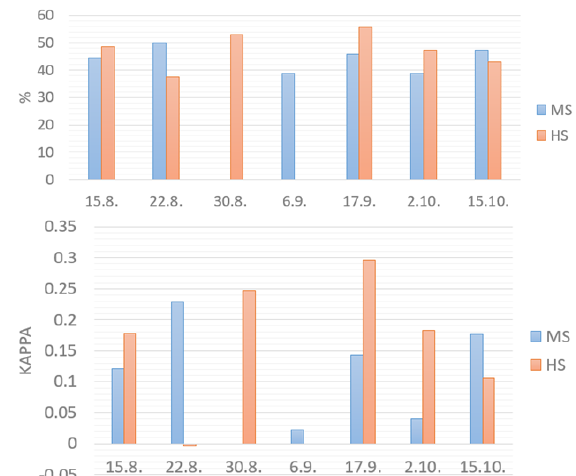
Figure 6. Overall accuracy (top) and kappa-coefficient of the health classification obtained with the leave-one-out error estimation method. MS: multispectral images; HS: Hyperspectral images.